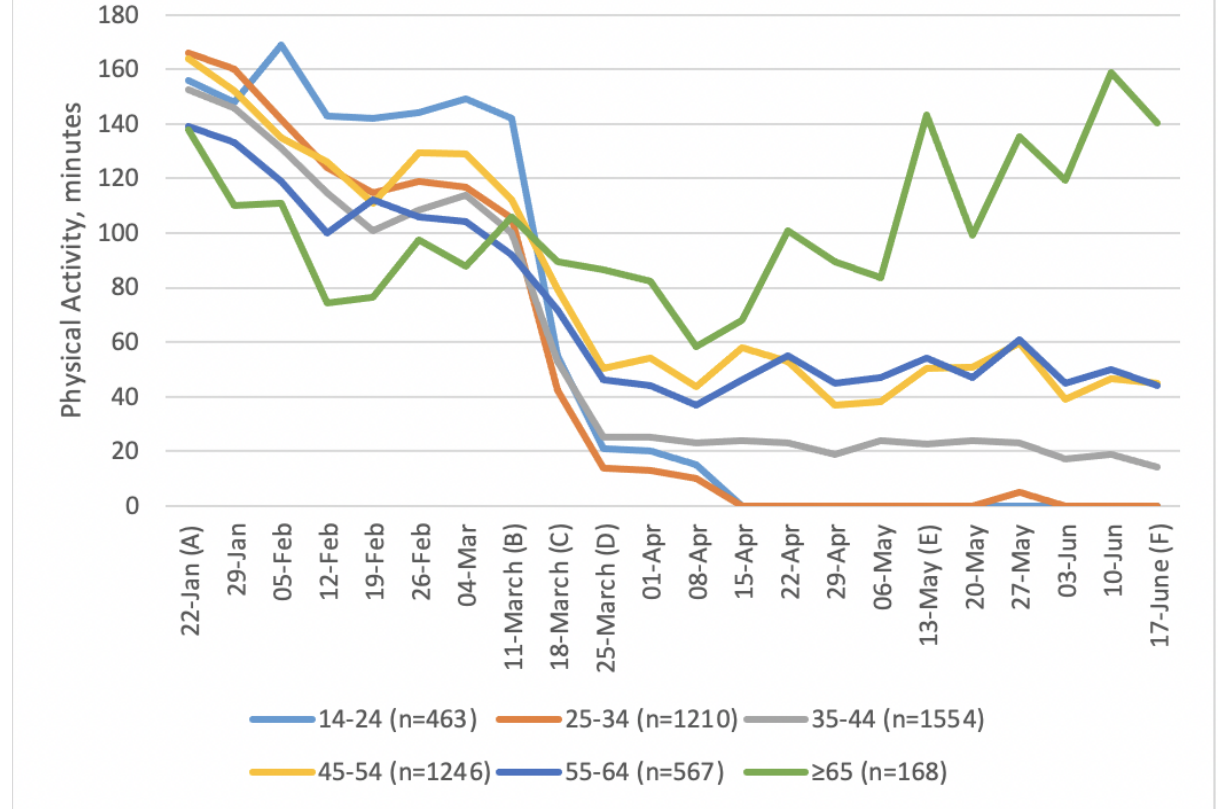
Figure 3. Weekly minutes (median) of activity by age. Important dates are marked on the x-axis as follows. (A) January 22: Baseline, week before first COVID-19 case announced in the United Kingdom. (B) March 11: Social distancing measures introduced. (C) March 18: Lockdown begins. (D) March 25: First full week of lockdown. (E) May 13: Lockdown measures relaxed. (F) June 17: Shops